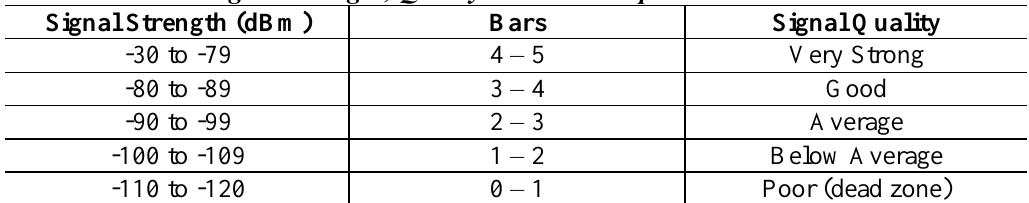
Table 1: Signal Strength, Quality and Bars’ Implications on Cell